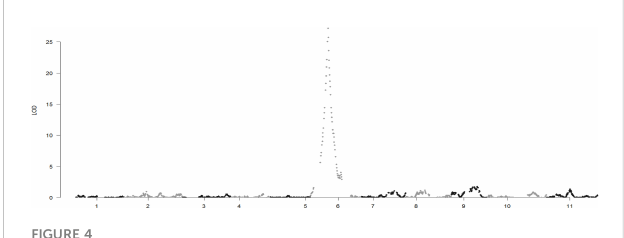
FIGURE 4 Genome-wide scan of QTLs for the thin seed coats in